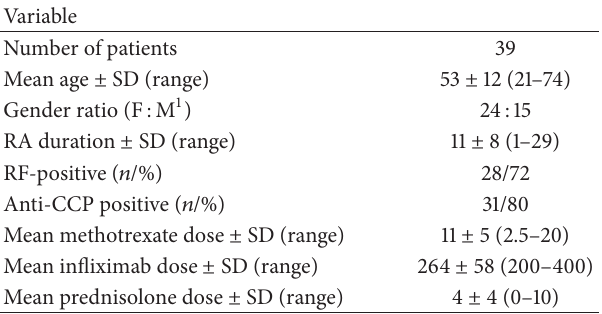
Table 2: Summary of the RA patient cohort data. Age and gender distribution and mean pharmacological